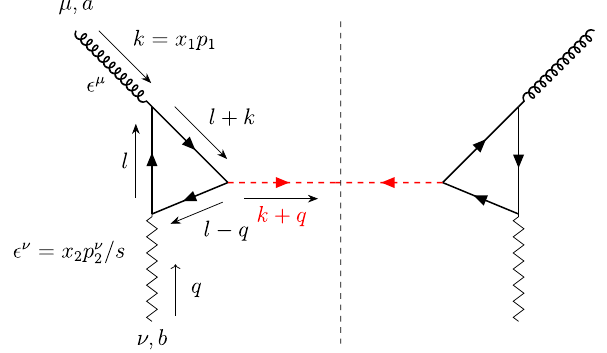
Fig. 3 Representative Feynman diagram for the squared modulus of the amplitude for the gluon scattering off a Reggeon to produce a Higgs particle. The Reggeized gluon is depicted by the zigzag